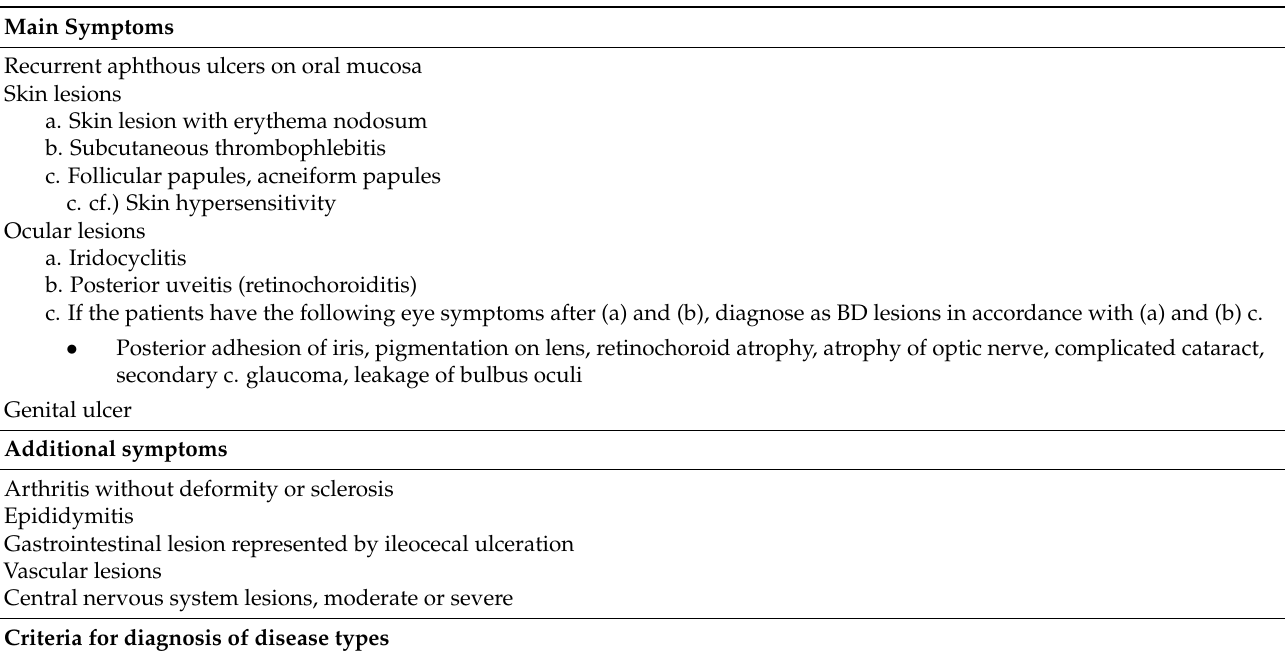
Table 3. Revised diagnostic criteria proposed by the Behcet’s Disease (BD) Research Committee of Japan.